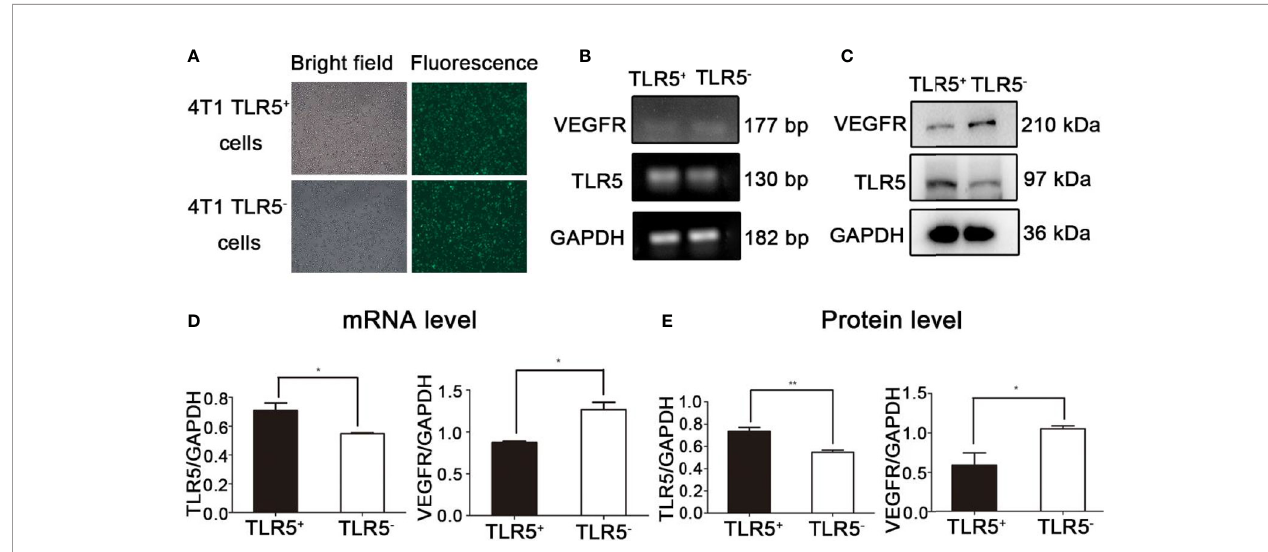
FIGURE 1 | Lentivirus-shRNA-TLR5 and negative lentivirus transfection ef fi ciency in 4T1 cells (A) . The TLR5 and VEGFR mRNA expression in TLR5 + and TLR5 ‐ 4T1 cells (n = 3, *P < 0.05) (B, D) . The TLR5 and VEGFR protein expression in TLR5 + and TLR5 − 4T1 cells (n = 3, *P < 0.05, **P < 0.01) (C, E)